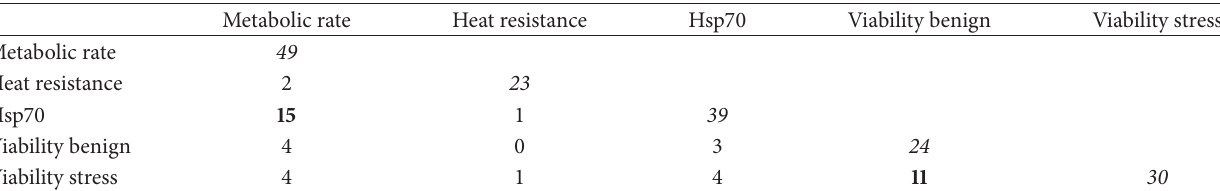
Table 2: Biological processes (a total of 689 GOs). Diagonal elements (italicized numbers) are the number of GOs with a 𝑝 < 0.05 . The off-diagonal elements show the number of elements shared between traits. Numbers in bold indicate a significant overlap. At a 𝑝 value of 0.05 one can expect 35 false-positive SNP-sets to be assigned as significant and two SNP-sets assigned as overlapping.